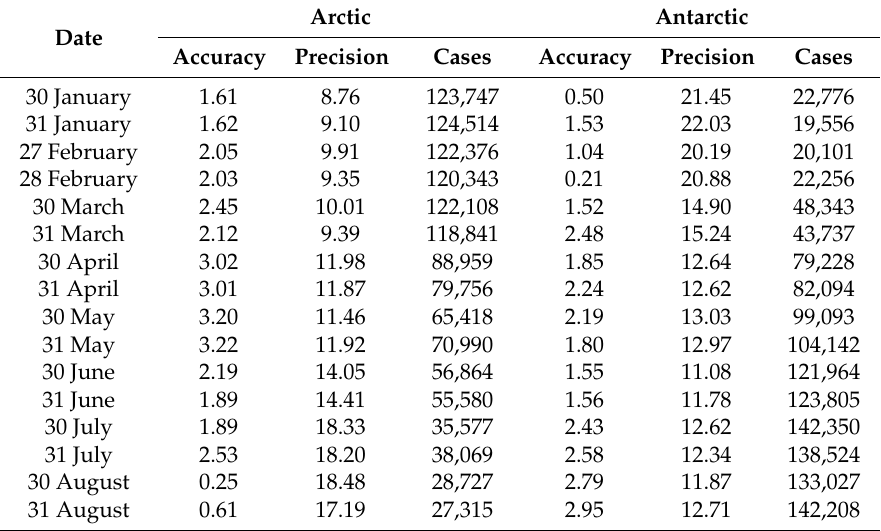
Table 3. Statistics for a comparison of VIIRS and AMSR2 ice concentration for cases in